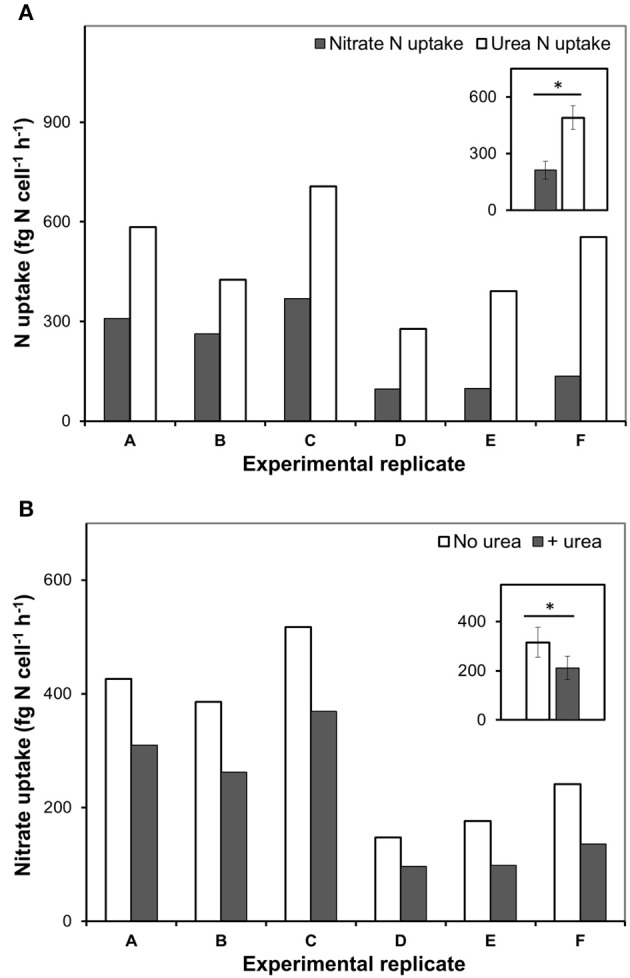
The urea and nitrate uptake by nitrate-acclimated P. minimum following the addition of urea. Insets show averaged data for all experimental replicates, the values are means ± 1 SE. The asterisks indicate significant differences between uptake rates. (A) The concurrent urea and nitrate uptake following the addition of urea. The urea-N uptake rate was significantly higher than the nitrate-N uptake rate (one-tailed Wilcoxon test, p < 0.05, n = 6). (B) Suppression of the nitrate uptake following the addition of urea. The nitrate-N uptake rate in the absence of urea was significantly higher than the nitrate-N uptake rate after urea addition (one-tailed Wilcoxon test, p < 0.05, n = 6).